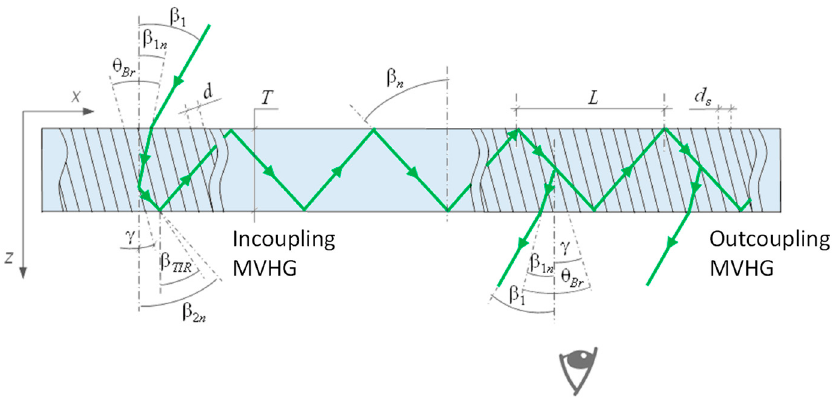
Figure 1. Scheme of radiation propagation in a waveguide plate. Diffraction geometry for a pair of VHGs of the input and output couplers. Parameters: β 1 , β 1 n —incident angles in the air and in the waveguide relative to the normal to the plate surface; θ Br —Bragg angle; β TIR —air defense angle; γ —angle of inclination of the diffraction grating; β 2 n —diffraction angle in the waveguide and the propagation angle relative to the normal to the plate surface; d —the volume grating period; d s —the surface period (period of the phase mask during the recording); T—thickness of the waveguide; L—length between the TIR points.